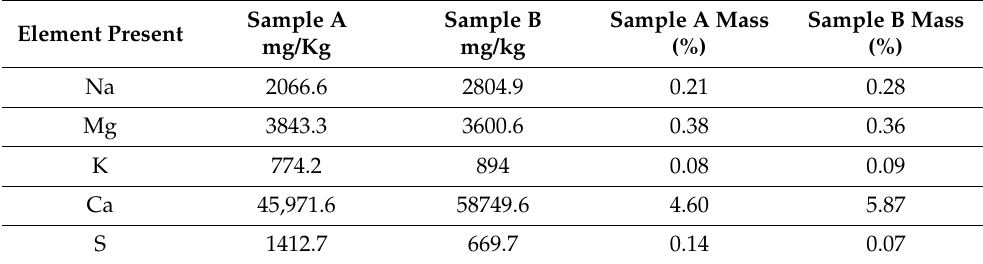
Table 1. ICP-OES elemental analysis.